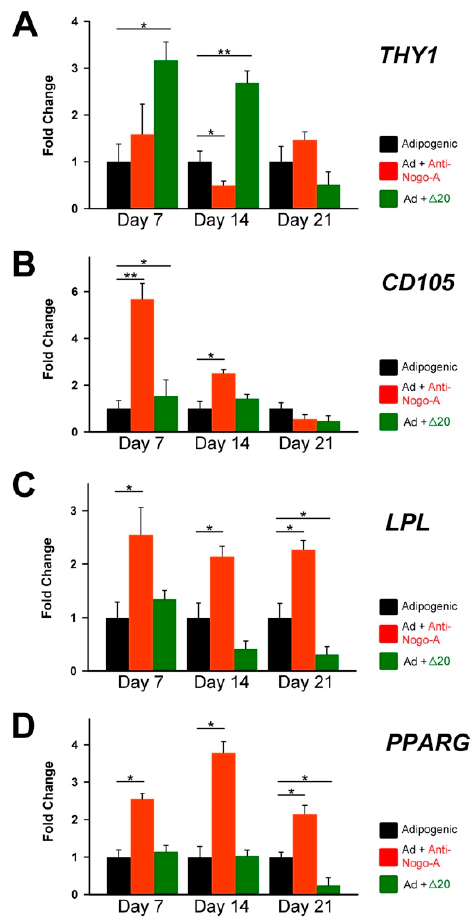
Figure 7. Effects of the Nogo-A protein and anti-Nogo-A antibody on the expression of genes during hDPSC adipogenic differentiation. qRT-PCR analysis of the relative expression levels of THY1/CD90 ( A ), END/CD105 ( B ), LPL ( C ) and PPARG ( D ) in hDPSCs cultured in adipogenic medium (Ad) alone (black columns), in adipogenic medium supplemented with the anti-Nogo-A-antibody (red colored columns), and in adipogenic medium supplemented with the Nogo-A ∆ 20 protein (green colored columns) for 7, 14 and 21 days. Values, normalized to GAPDH, shown are the mean ± SD of triplicates. Statistical analysis used Student’s t-test (significant difference at *, p < 0.05; **, p <